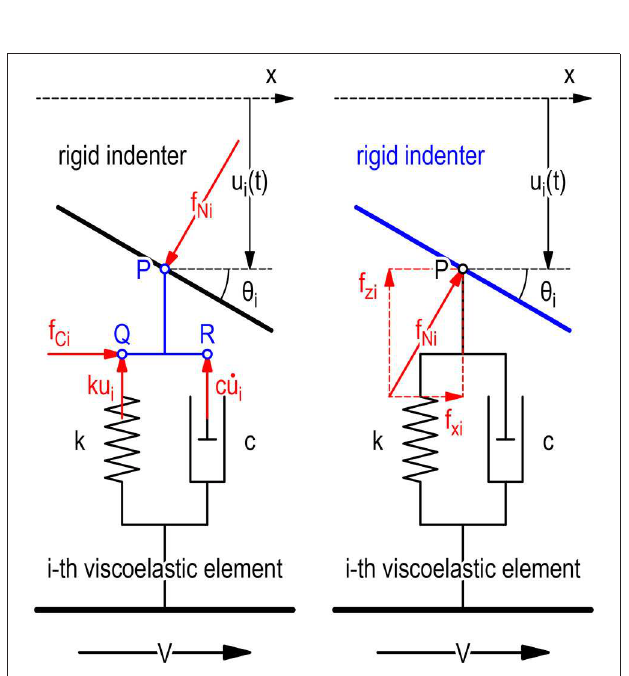
FIGURE 2 | Local forces on the i th viscoelastic (Kelvin–Voigt) element. (Left) Local forces acting on subelement PQR in the i th viscoelastic element. (Right) Local force acting on rigid indenter from the i th viscoelastic